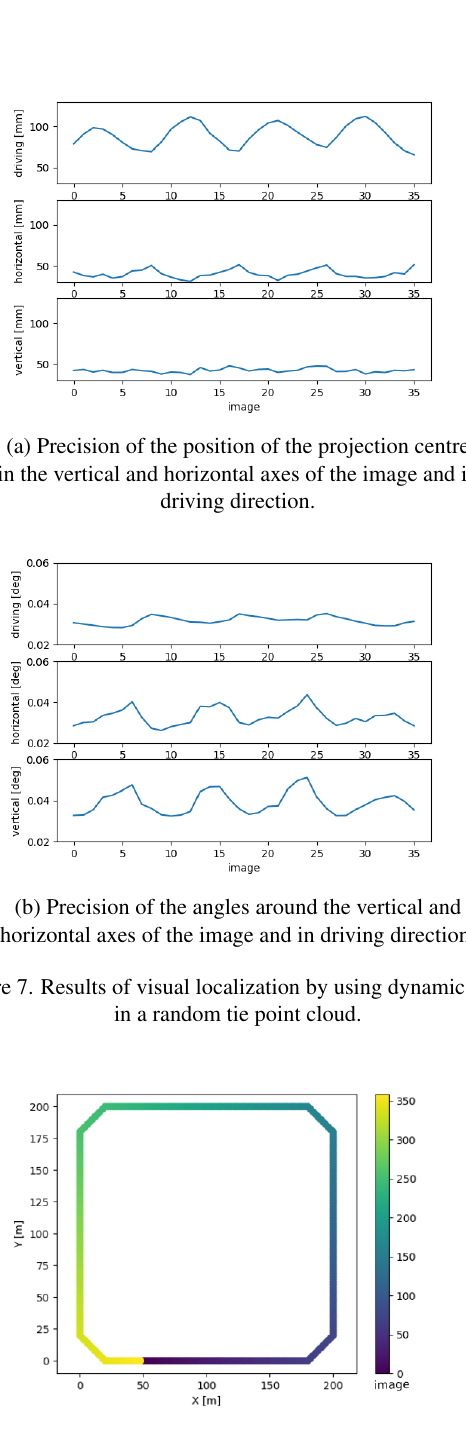
Figure 8. Distribution of images for the window-based approach. The image number is color